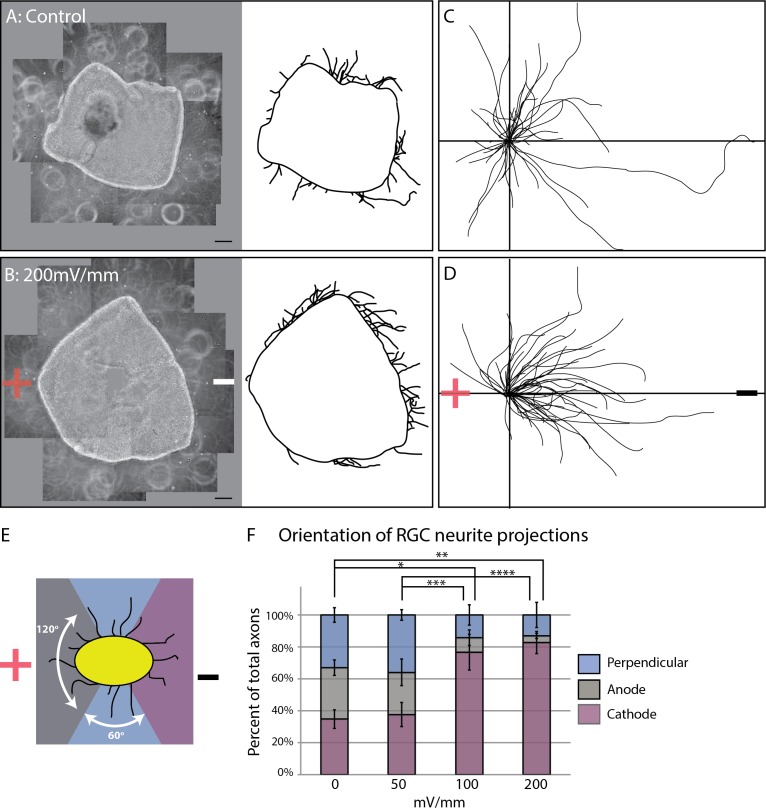
Retinal neurites grow directionally toward the cathode. Retinal explants were grown overnight, then exposed to an EF for 4 hours. (A) Control culture. (B) Culture exposed to EF of 200 mV/mm (cathode on right; anode on left). Left: Composite image of culture. Right: Tracing of explant and all neurites projecting from explant edge. (C, D) Composite of traced neurites from (A, B). See Methods. (E) Schematic of neurite quantification algorithm: gray: anode facing, purple: cathode facing, blue: perpendicular to EF. (F) Retinal explants were exposed to varying strengths of EFs. Neurites projecting from explant edge were quantified as schematized in (E) and represented as percent of total neurites growing toward cathode or anode versus perpendicular to EF. Significantly more neurites demonstrated cathode-directed growth when exposed to an EF of 100 or 200 mV/mm than 0 or 50 mV/mm (*; **; ***; ****P < 0.001; 2-way ANOVA). Error bars represent standard deviation (SD). Scale bar: 100 μm.